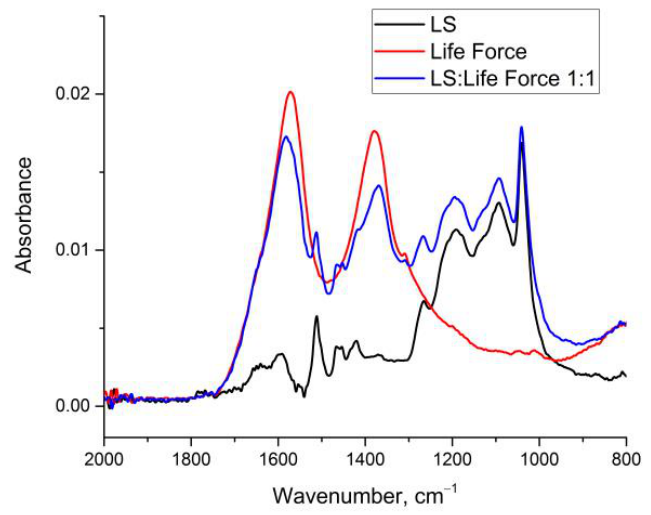
Figure 5. ATR absorption spectra of centrifuged aqueous solutions of sodium lignosulfonate, sodium humate Life Force, and their 1:1 mixture.